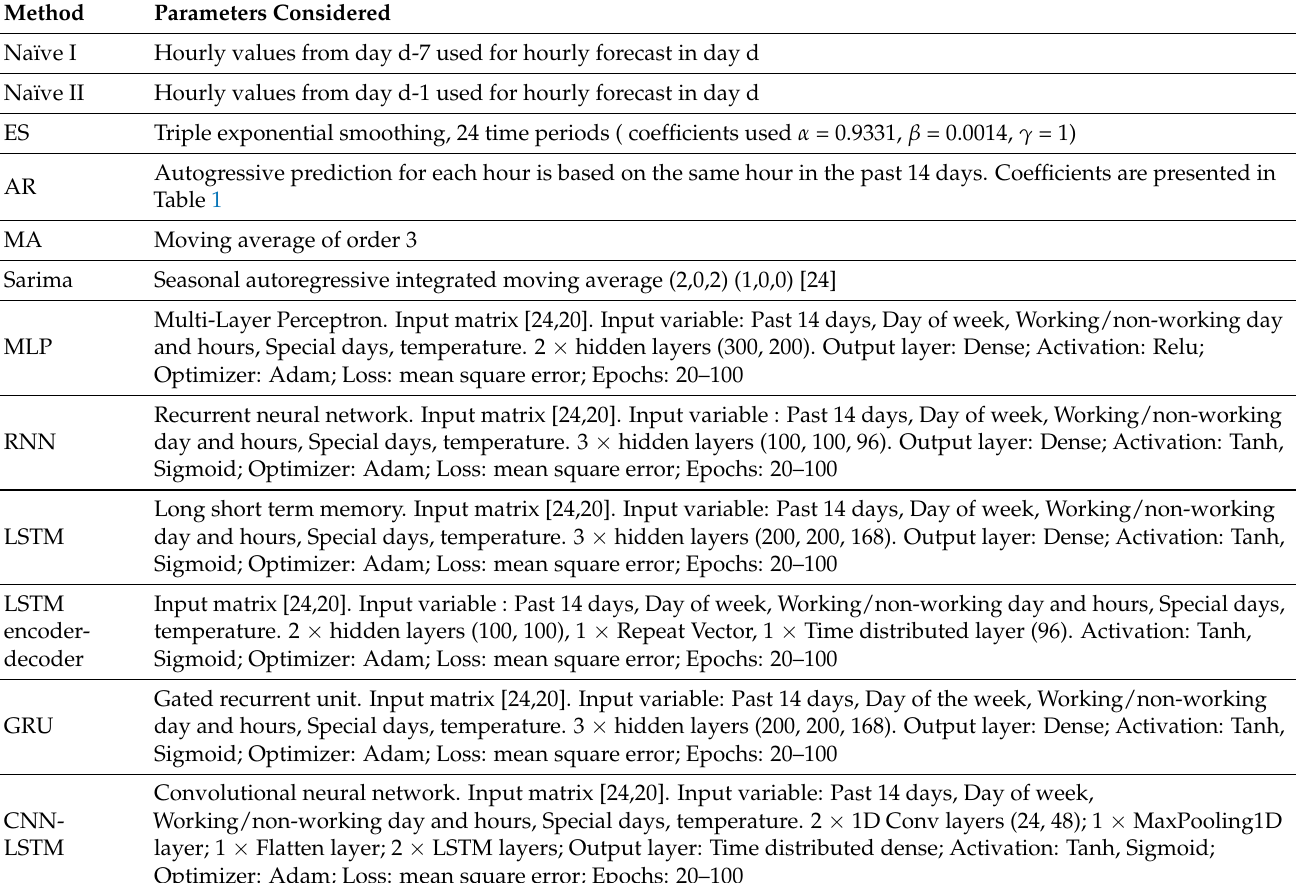
Table 2. Parameters used by the forecast methods implemented in this